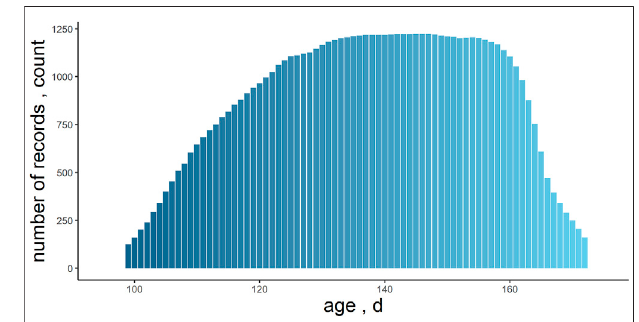
FIGURE 1 | Distribution of daily records number with days of age increasing in